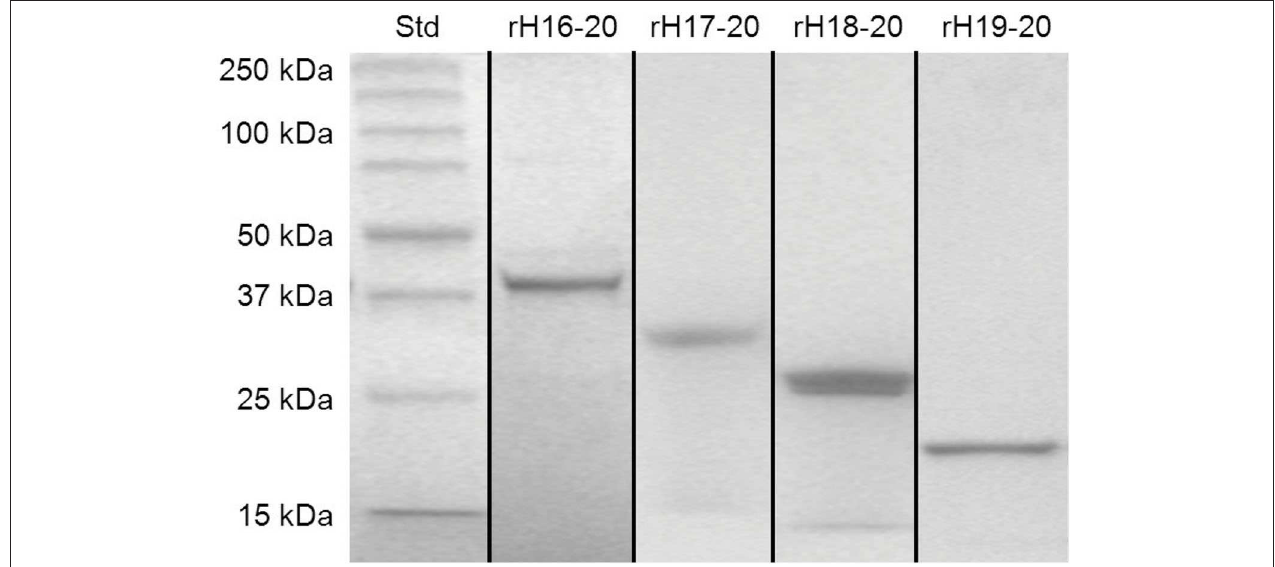
FIGURE 2 | SDS-PAGE of purified fragments of human Factor H. Recombinant proteins were expressed in High Five insect cells grown in serum free media. The proteins were purified from the media by ion exchange and affinity chromatography. Proteins spanning the C-terminal domains of Factor H (rH 16-20, rH 17-20, rH 18-20, and rH 19-20 with calculated molecular weights of 39, 32, 26, and 19 kDa, respectively), and standards with the indicated size were electrophoresed through 8–16% gradient polyacrylamide gels under reducing condition and stained with Coomassie blue dye. Figure is a composite of multiple gels.